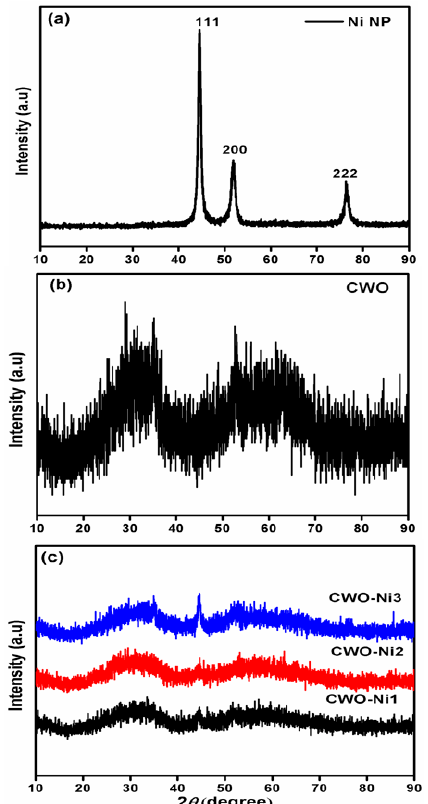
Figure 1. X-ray diffraction (XRD) patterns of the ( a ) Ni nanoparticles; ( b ) CoWO 4 (CWO); and ( c ) Figure 1. X-ray di ff raction (XRD) patterns of the ( a ) Ni nanoparticles; ( b ) CoWO 4 different composites of CWO–Ni1, CWO–Ni2, and CWO–Ni3.